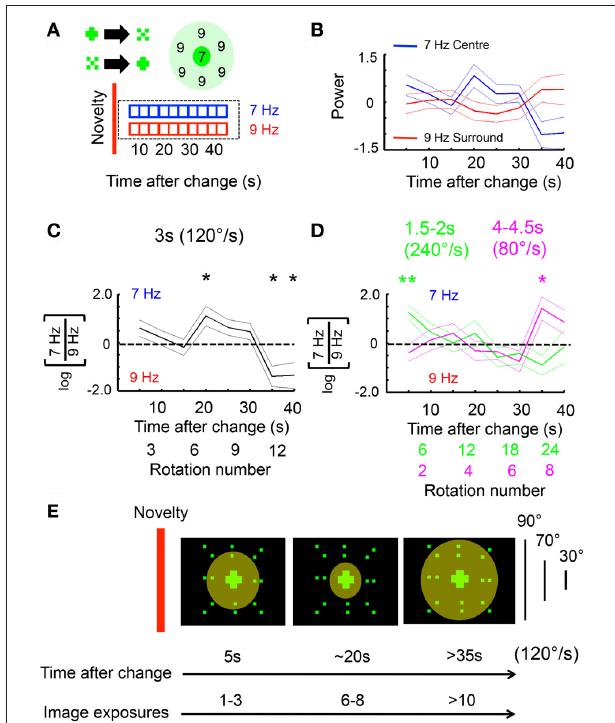
FIGURE 5 | Ongoing frequency tag dynamics are tied to pattern velocity. (A) 7Hz (center) and 9Hz (surround) power was calculated for a 3s, moving window following a visual change, for an uninterrupted 40s (see “Materials and Methods”). (B) Average log-normalized and zero-meaned 7 and 9Hz power ( ± SEM) plotted over time, following a novelty event ( n = 12 male flies). (C) Average log-ratio of 7Hz/9Hz ( ± SEM) for the same data as in B. ∗ P < 0 . 05, by t- test compared to zero (dashed line; greater 7Hz power is above the line, greater 9Hz below). The number of rotations is indicated below the time axis. (D) The same 7/9Hz log-ratio analyses were performed on faster (green) and slower (magenta) moving objects. ∗ P < 0 . 05, ∗∗ P < 0 . 01, by t- test compared to zero. The approximate number of rotations for either image velocity condition is indicated by matching color below the time axis. (E) A model of the spatio-temporal dynamics of LFP frequency tag effects following a visual change in the center (red bar). The diameter of the circle indicates the size of a hypothesized attention “spotlight.” The corresponding number of image exposures at different times is indicated for an object moving around the fly at 120 ◦ /s. The angle subtended by the different object components (surround, area inside surround, and center) is